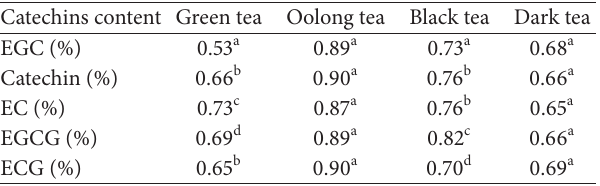
Table 3: Correlation coefficients for correlation of ORAC value and catechins content in different tea infusions.